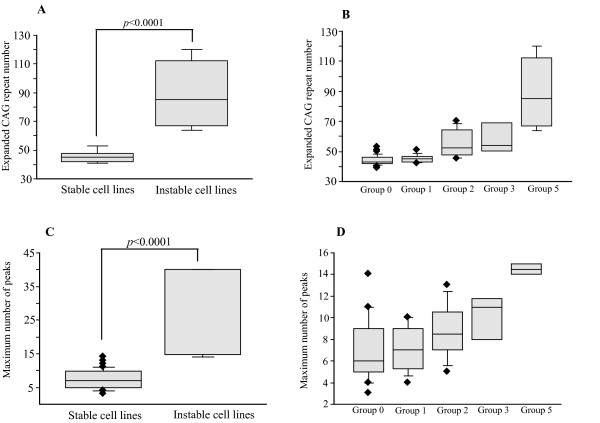
Instable cell lines with (ΔCAG ≥ 5) and stable cell lines with no or small (ΔCAG ≤ 3) CAG repeat variation in dependence on expanded CAG repeat number and mosaicism. A, Expansion CAG mutations are significantly larger in instable cell lines with ΔCAG ≥ 5 (n = 55; 89.4 ± 11.1 CAG) than in those with ΔCAG ≤ 3 (n = 55; 46.6 ± 0.10 CAG). B, Relationship between ΔCAG magnitude and expanded CAG repeat number. Groups 0, 1, 2, 3 and 5 represent cell lines with a ΔCAG value of 0, 1, 2, 3, and ≥ 5 repeats, respectively. The higher ΔCAG magnitude, the more significant is the statistical difference with Group 0-cell lines. Groups 2, 3 and 5 all showed a significant difference vs Group 0 (p-values = 0.0009, 0.0041 and < 0.0001, respectively). C, The mosaicism level, calculated by counting the maximum number of peaks, is significantly lower for stable cell lines with no or small repeat variation (n = 55, 7.4 ± 2.8 peaks and ΔCAG ≤ 3), than for those with large CAG changes (n = 5, 29.9 ± 13.7 and ΔCAG ≥ 5). D, The mosaicism level in dependence on ΔCAG: Samples with more than 80 CAG and about 40 peaks excluded as outliers to avoid a possible bias. Cell lines with large ΔCAG variations ≥ 5 CAG repeats showed an increased number of peaks and mosaicism vs each of the other groups with lower CAG variation (p-values = 0.0003, 0.0007, 0.0086 vs cell lines with ΔCAG = 0, 1 and 2 repeats, respectively). Diamonds in panels B, C and D represent outliers. Standard deviation is reported at the top of each bar.